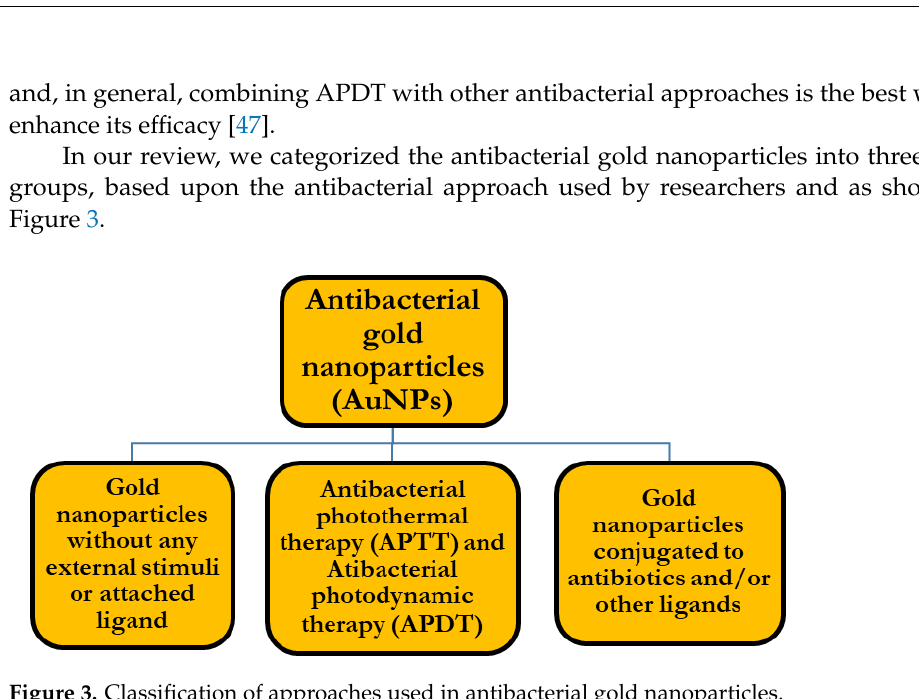
Figure 3. Classification of approaches used in antibacterial gold nanoparticles.